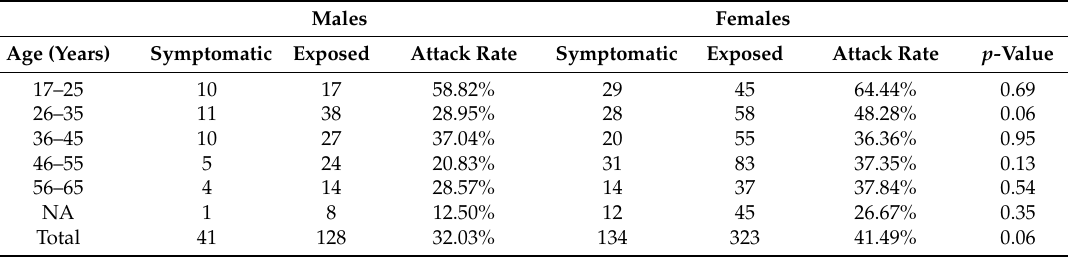
Table 1. Attack rates in workers by age and sex.